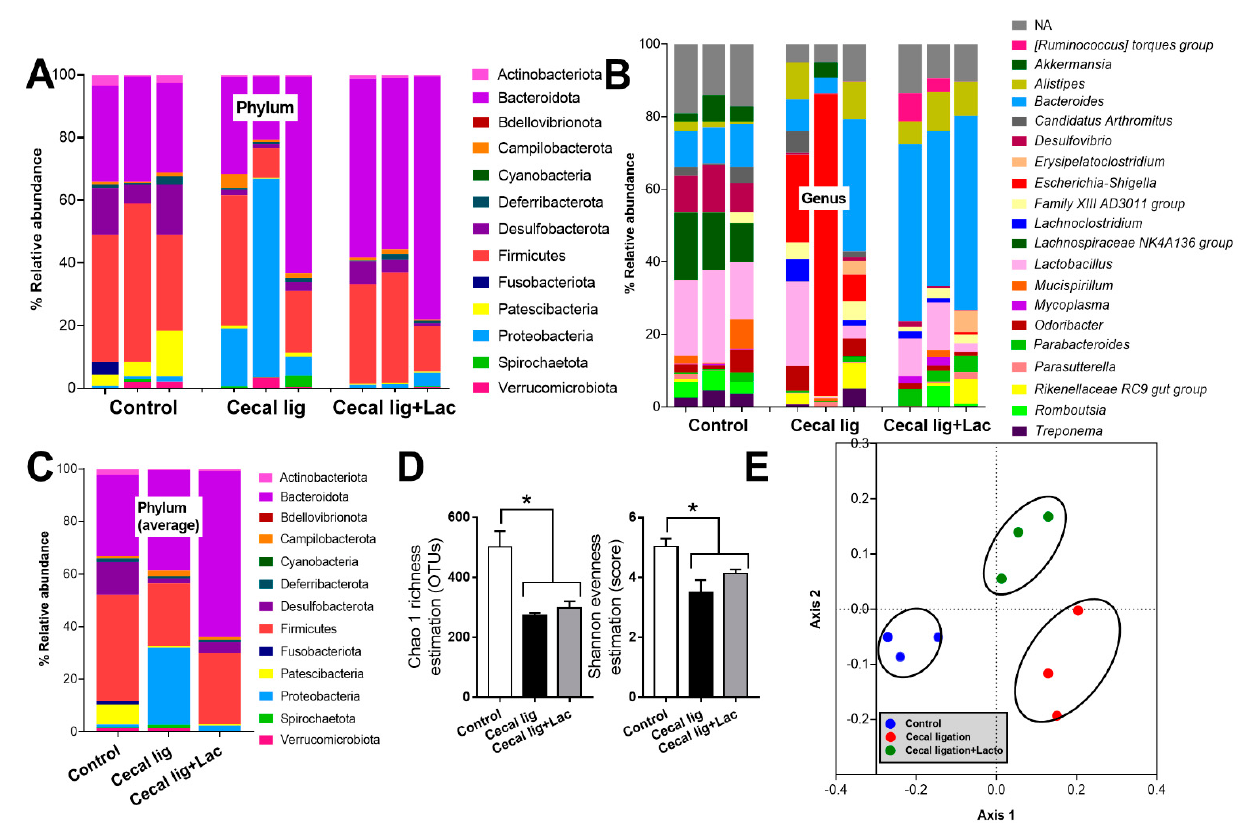
Figure 3. The characteristics of fecal microbiome analysis from mice with cecal ligation (without puncture) (Cecal lig) or sham surgery (Sham) with or without Lacticaseibacillus administration (Cecal lig + Lac and Sham + Lac) as indicated by the abundance of bacteria in phylum, genus, and the average value on phylum ( A – C ), the alpha diversity (Chao 1 richness estimation and Shannon evenness evaluation) ( D ), and the non-metric multidimensional scaling (NMDS) ( E ) are demonstrated. * p < 0.05.